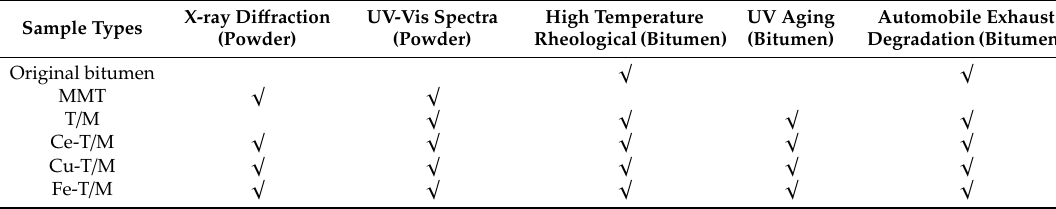
Table 2. The summary of samples and experiments in the